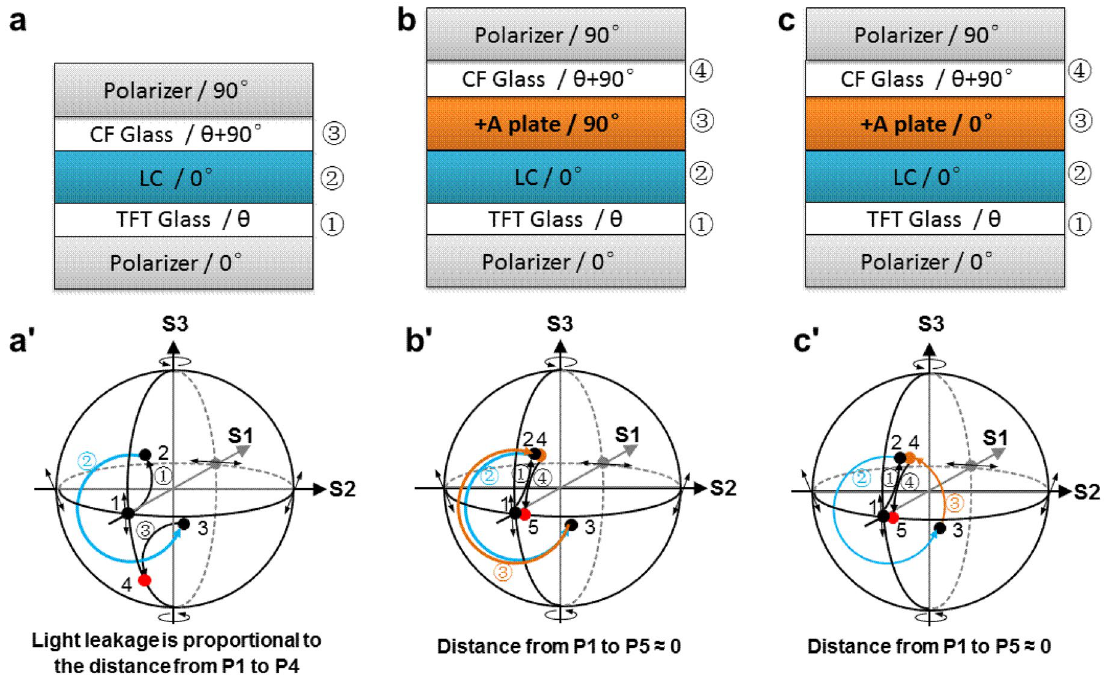
Figure 2. The compensation principle of the new IPS. ( a ) The structure of normal IPS. ( a ’) The stressed LL principle of normal IPS. ( b ) The structure of compensation mode 1. ( b ’) The compensation mechanism of compensation mode 1. ( c ) The structure of compensation mode 2. ( c ’) The compensation mechanism of compensation mode